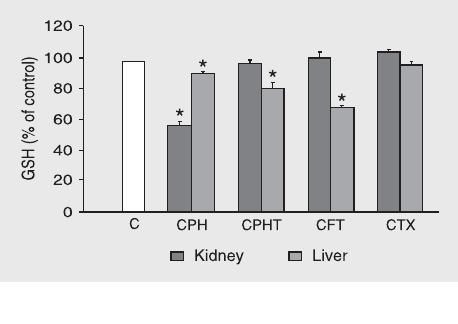
Figure 2. Time course of plasma malondialdehyde (MDA) con- centration after ip administration of cephaloridine. Open circles = control (no cephalosporin); filled circles = 200 mg kg -1 day -1 ; open squares = 500 mg kg -1 day -1 ; filled squares = 1000 mg kg -1 means ± SD for at least 5